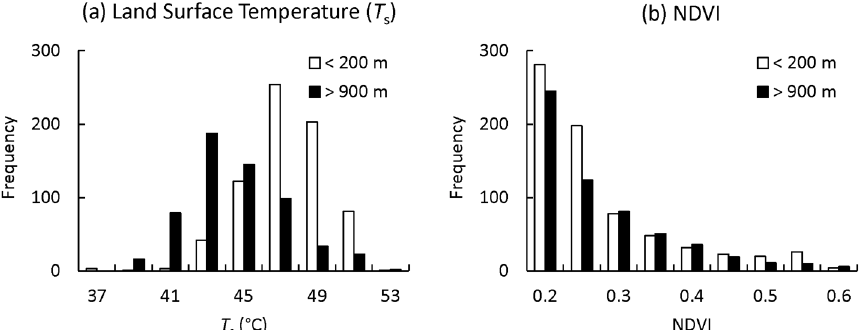
Figure 2. Histograms of ( a ) land surface temperature and ( b ) NDVI on 13 August of 2009 in two elevation zones, below 200 m and above 900 m, respectively. Considering the period 1970 to 2013, 2009 was an average rainfall year.